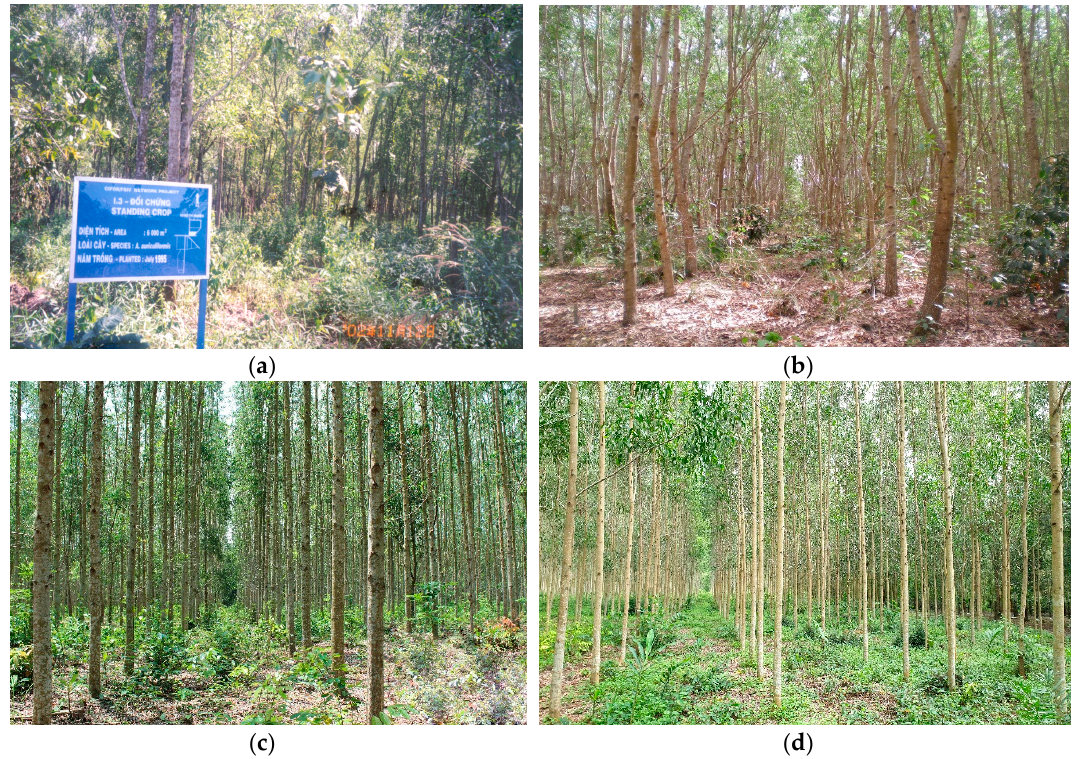
Figure 2. Stand structure and features for four successive rotations of A. auriculiformis grown under changing management regimes, over 25 years, in south Vietnam. ( a ) First rotation (planted 1995) at seven years of age, ( b ) second rotation (planted 2002) at an age close to six years; ( c ) third rotation (planted 2008) at 6.5 years of age and ( d ) fourth rotation (planted 2016) at three years of age.